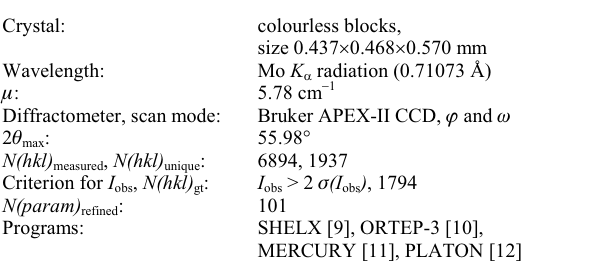
Table 1. Data collection and handling.